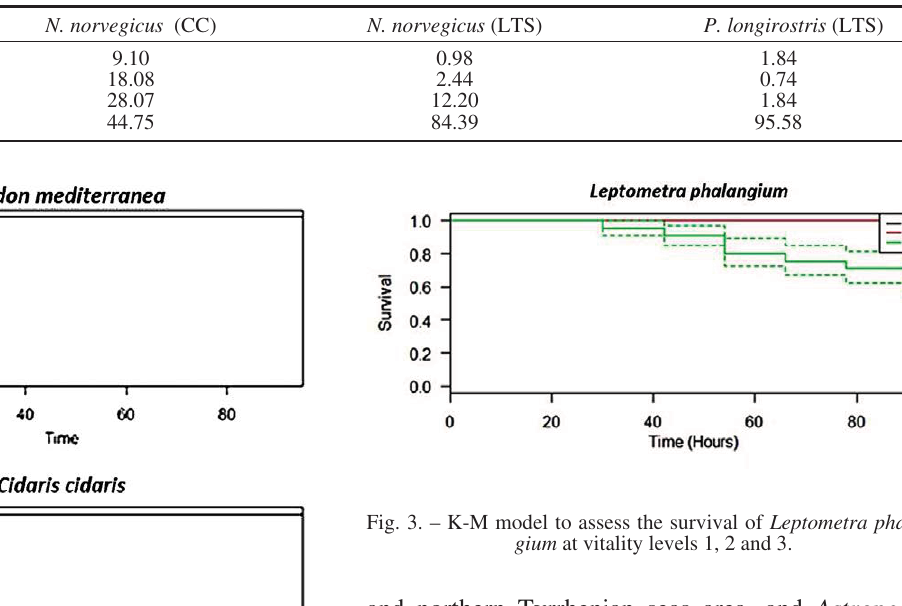
Table 4. – Percentages of the four vitality levels in each study area for the two species of invertebrates subjected to minimum conservation reference sizes. CC, Catalan coast; LTS, Ligurian and northern Tyrrhenian seas.